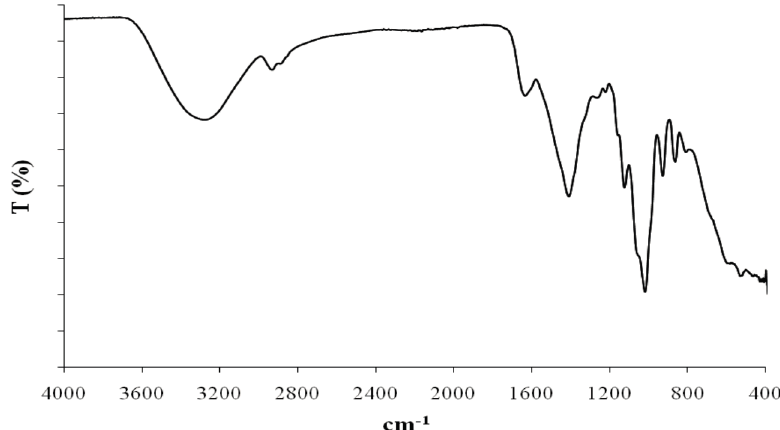
Figure 5. IR spectrum of the EPS1 produced by B. licheniformis strain